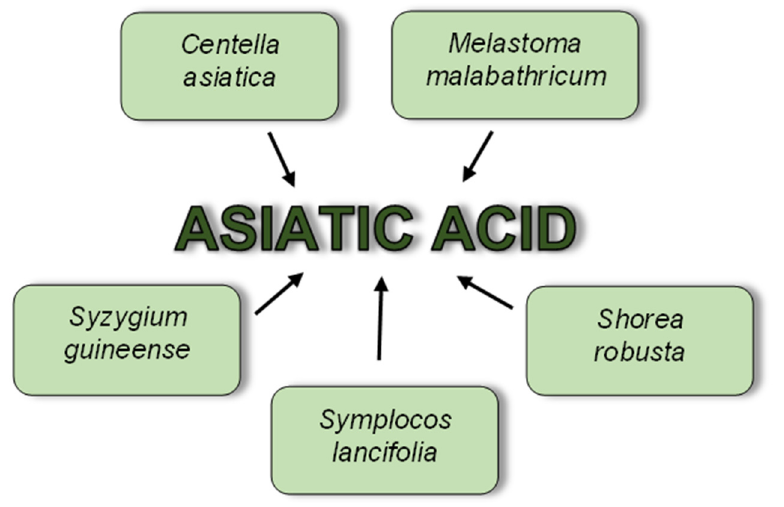
Figure 3. Plant sources of asiatic acid used in antibacterial experiments; green